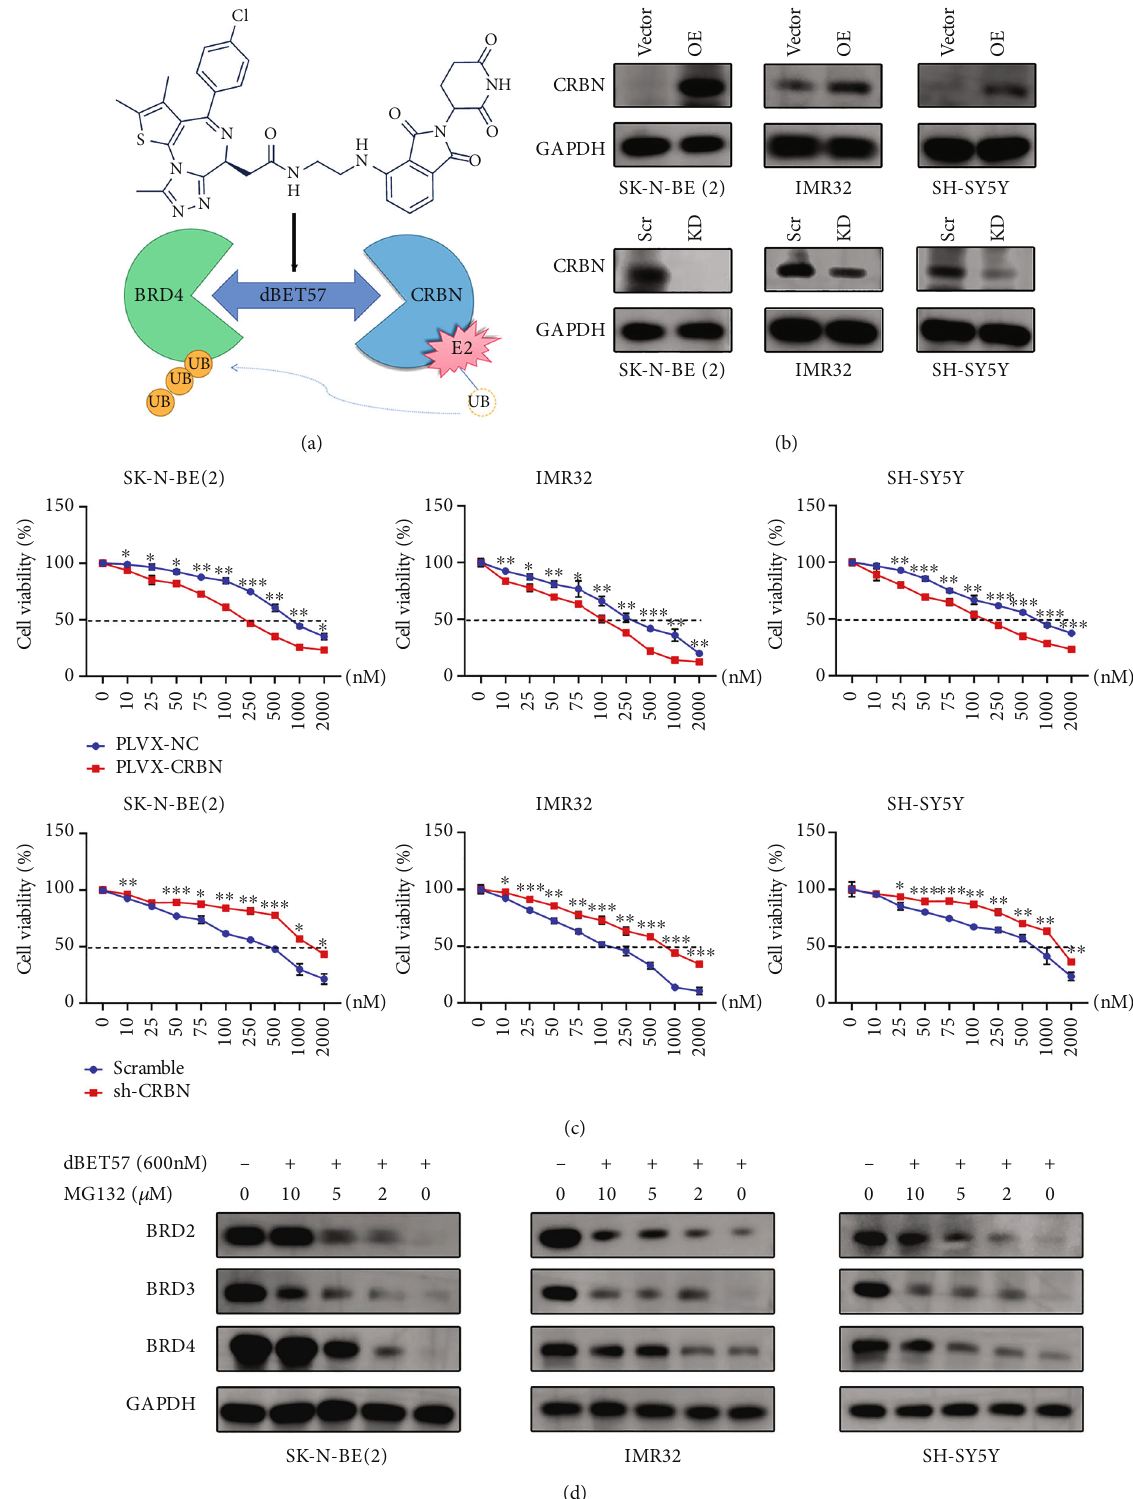
Figure 4: CRBN is indispensable for the sensitivity of dBET57. (a) Chemical formula and reaction diagram of dBET57. (b) Western blotting showed the protein expression levels of CRBN in NB cells transfected with lentiviral sh-CRBN (or PLVX-CRBN). Scr: scramble; KD: knockdown; OE: overexpression. (c) The sensitivity of NB cells transfected with sh-CRBN (or PLVX-CRBN) to dBET57 was compared with NB cells transfected with empty vector alone. (d) Western blot analysis showed that MG132 and dBET57 cotreated NB cells 24h, the expression level of BET proteins. ∗ p < 0 : 05 , ∗∗ p < 0 : 01 , and ∗∗∗ p < 0 : 001 ; ns: not signi fi